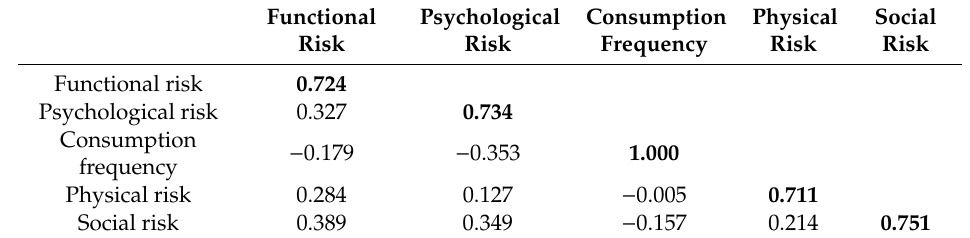
Table 5. Fornell-Larcker test of discriminant validity.